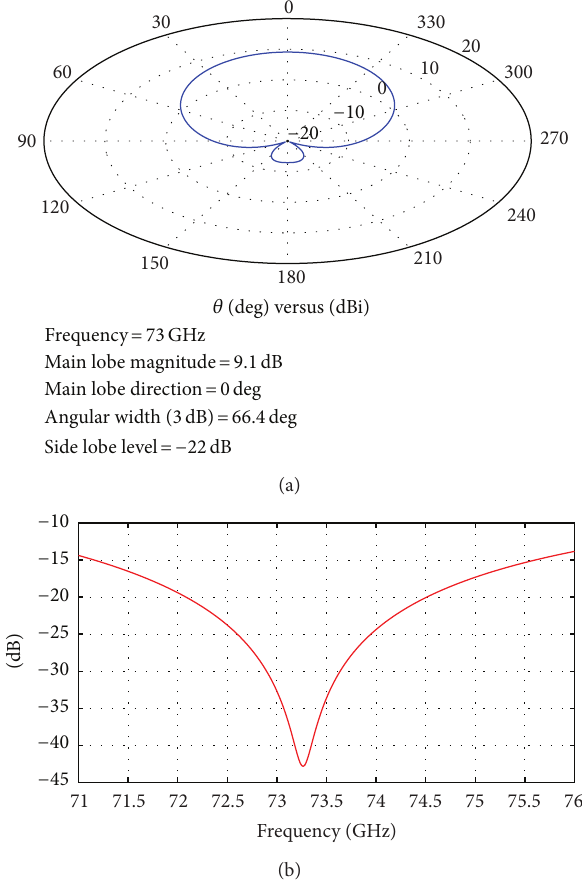
Figure 5: Designed patch performances: (a) radiation pattern (b) reflection coefficient